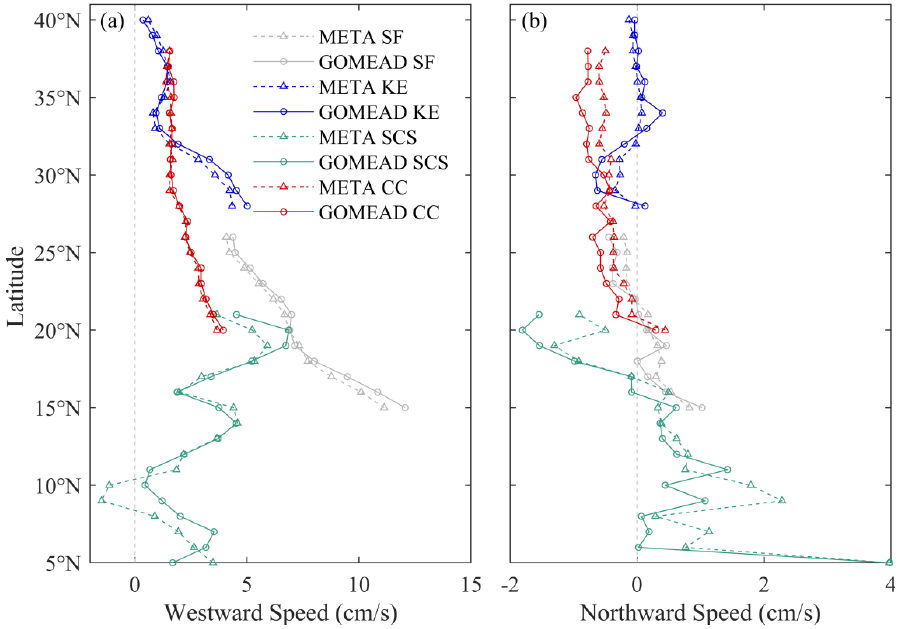
Figure 14. Variations of ( a ) westward speeds and ( b ) northward speed of AEs by latitude. Dashed and solid lines represent results from the META and GOMEAD datasets, respectively.